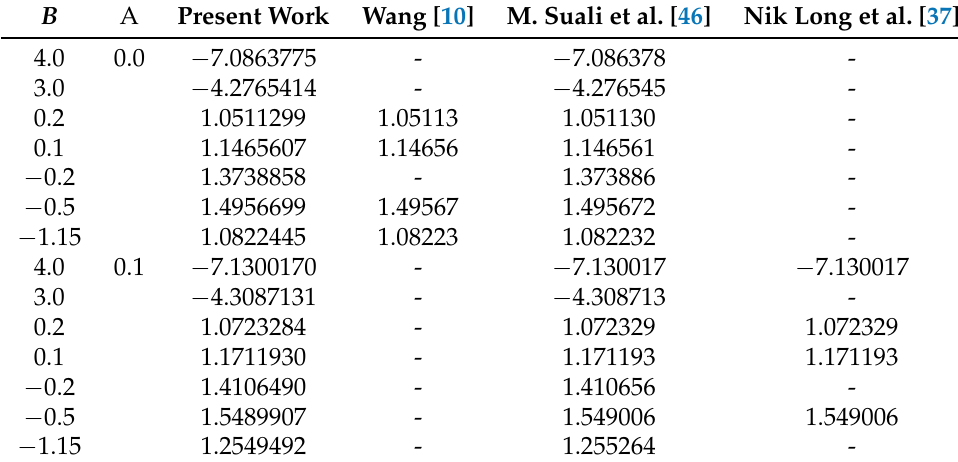
Table 4. Comparison of f (cid:48)(cid:48) ( 0 ) when A = 0 and A = 0.1.